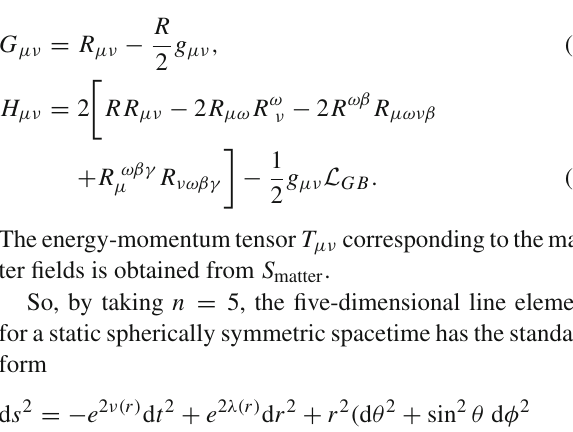
Fig. 1 Variation of metric potentials for 4U 1538-52 using the param- eter provided in Table 1